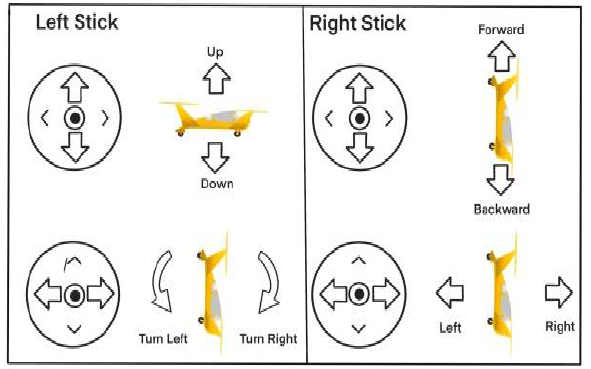
Figure 12 . Joysticks